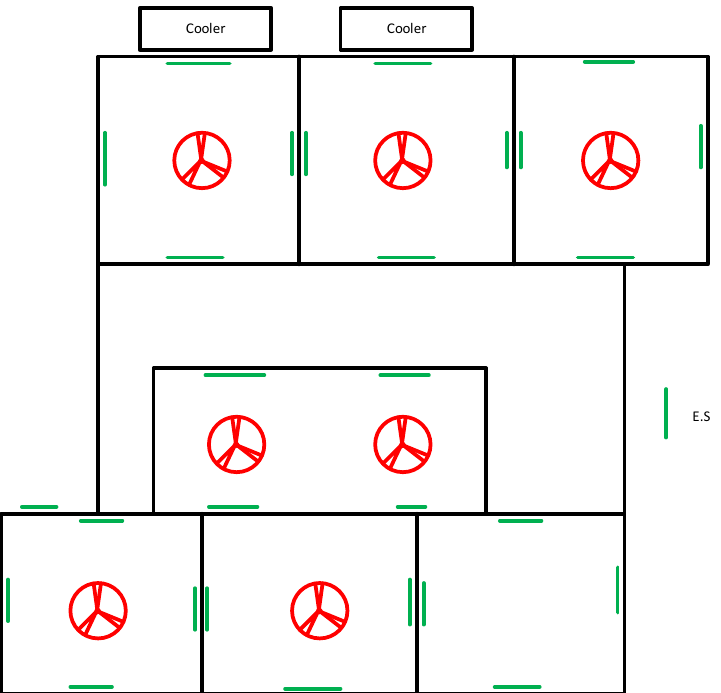
Figure 8. Sketch of the Staff